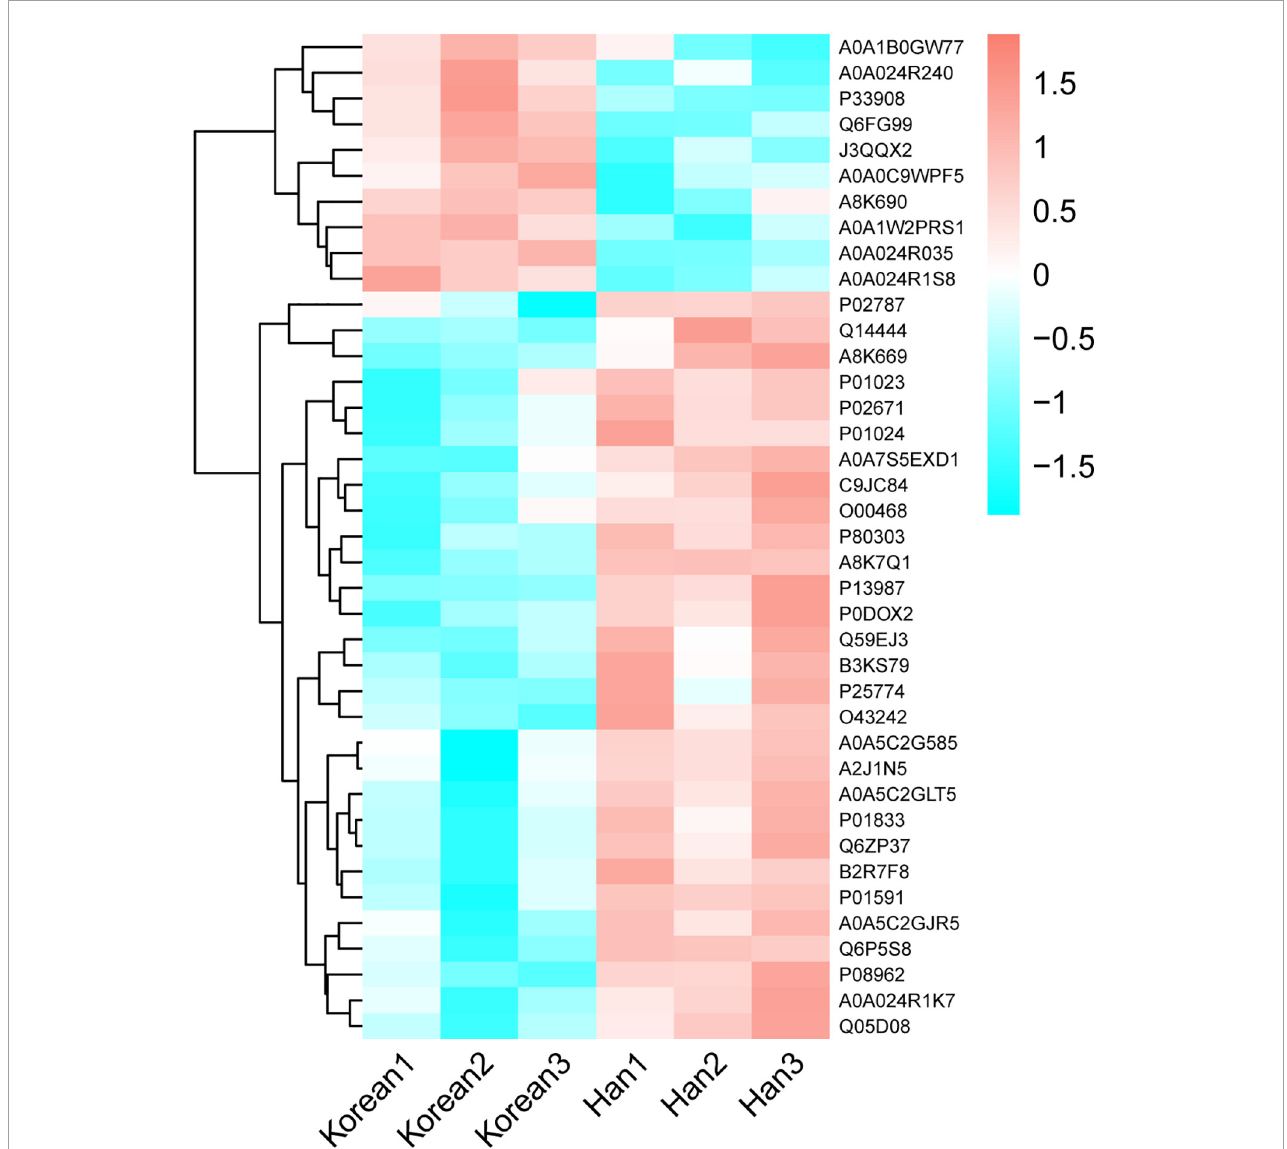
FIGURE5 Hierarchical clustering of differentially expressed caseins from Korean and Han ethnic groups in China. Each column is a group. Each row is a protein. Red part represents a significantly upregulated protein, cyan part represents a significantly downregulated protein, and white part represents a protein that does not change